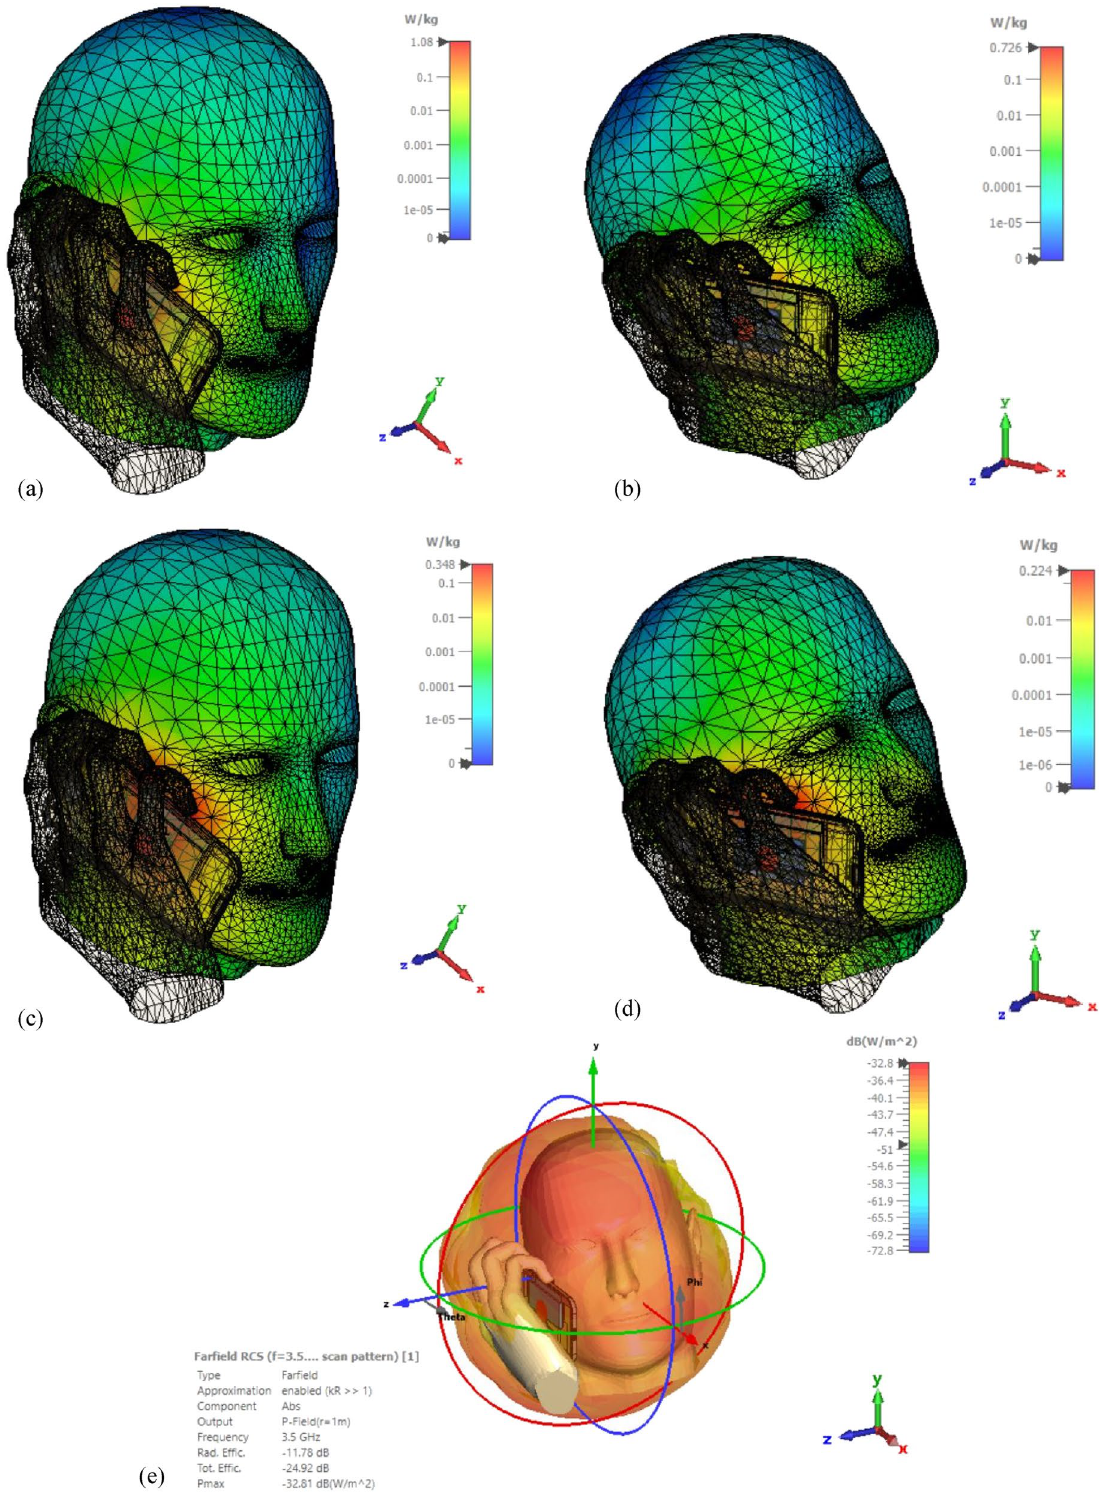
Figure 9. Calculated specific absorption rate (SAR) from CST simulation of the “Phantom” for 1gm averaging mass ( a ) without absorber, ( b ) with absorber, and for 10 gm averaging mass ( c ) without absorber and ( d ) with the absorber. ( e ) The maximum radiation power by the 3.5 GHz antenna in the presence of the absorber. [The images were taken from the component library of CST studio suite 2021 software and edited, URL: https:// www. 3ds. com/ produ cts- servi ces/ simul ia/ produ cts/ cst- studio-